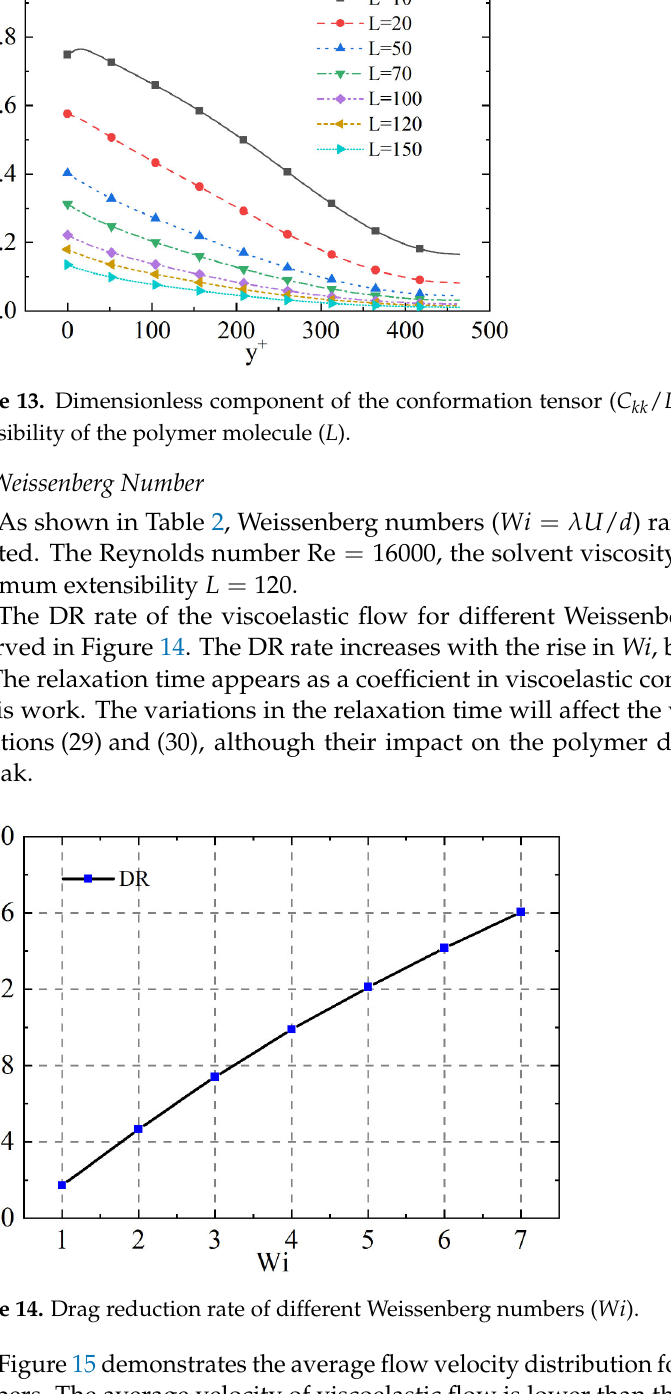
C L ) of different maximum kk